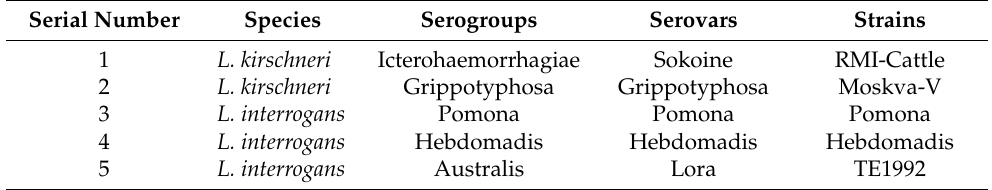
Table 1. Species, serogroups, serovars and strains used in